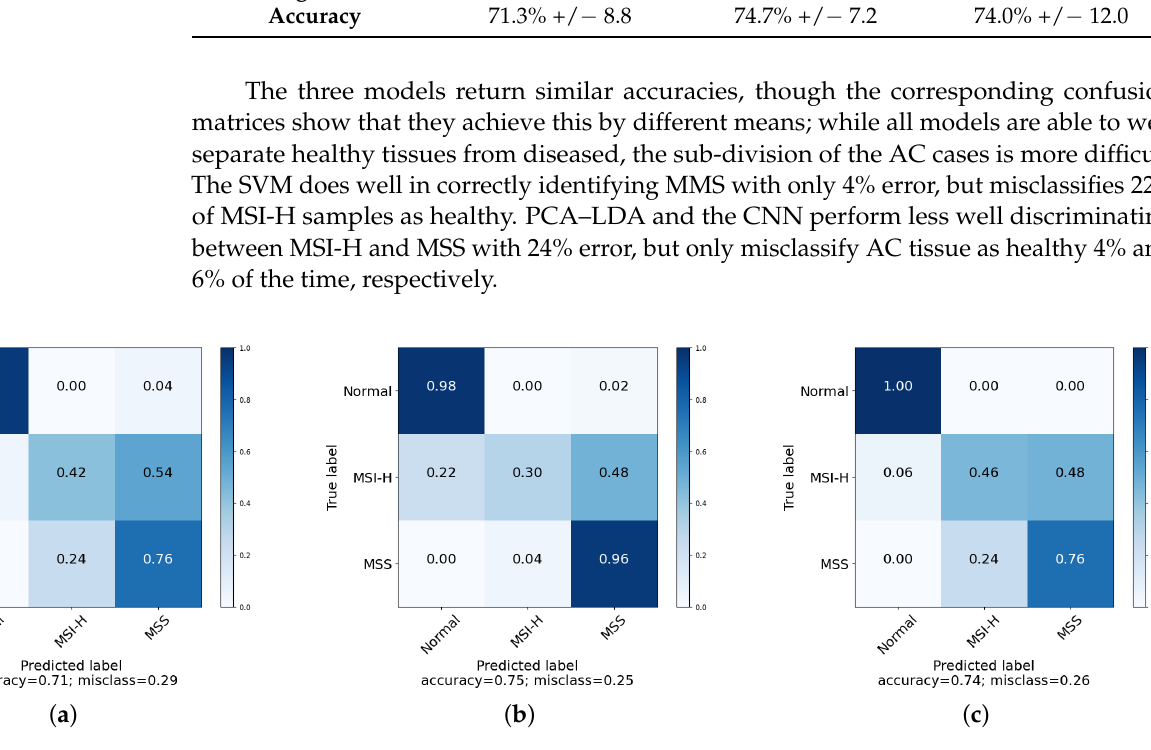
Figure 6. Confusion matrix for ( a ) PCA–LDA ( b ), SVM ( c ),